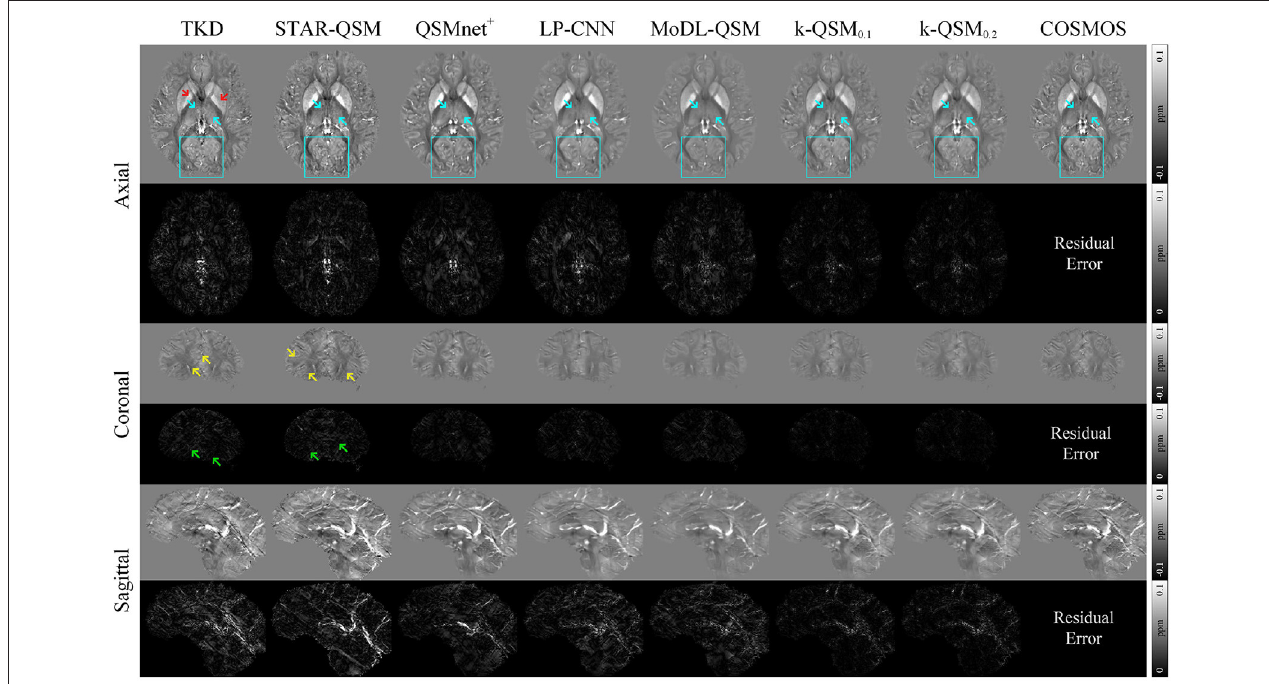
FIGURE 3 | Three orthogonal views of quantitative susceptibility mapping (QSM) reconstruction (average of five orientation samplings) using different methods on data from the FM Kirby Research Center. The k-QSM result shows more details and textures (cyan arrows and boxes) than other deep learning methods. Truncated k-space division (TKD) (thr = 0.2) and STAR-QSM can reconstruct the details but with insufferable streak artifacts (yellow arrows). Red arrows mark lower susceptibility of TKD than COSMOS. Green arrows indicate artifacts in residual error maps.